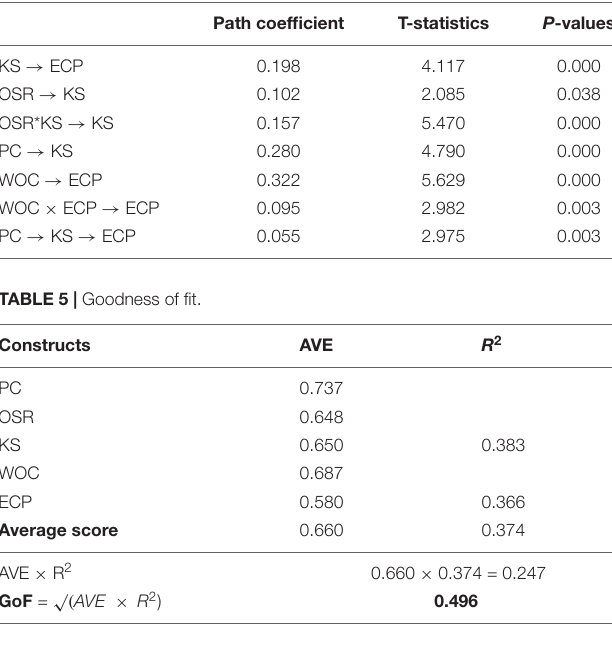
TABLE 4 | Path coefficients with P -values.